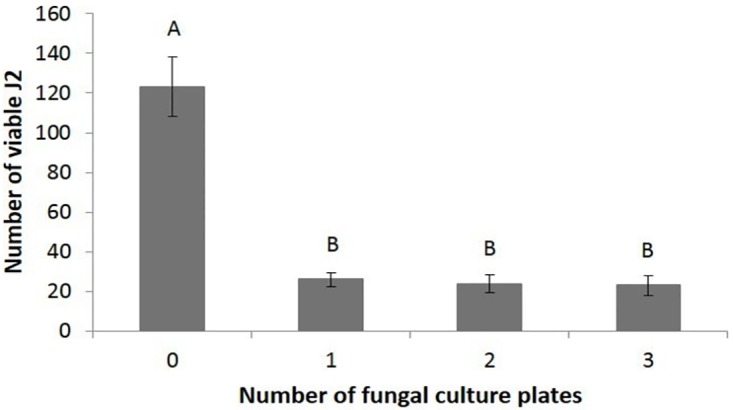
Effect of D. cf. concentrica culture plate on M. javanica J2 viability.J2s were exposed to 0–3 culture plates of D. cf. concentrica for 48 h. The numbers on the x-axis represent the numbers of Petri plates (50 mm in diameter, containing 5 mL of growth medium, and the fungal culture) in each 1-L sealed box. The number 0 indicates control treatment in which the nematodes were not exposed to the fungal culture plate. The viable J2s were separated using 30 μm sieves, and the numbers on the y-axis represent the numbers (mean ± SE) of viable J2s counted following the incubation. There were 10 repetitions, each using 300 J2s. The results were subjected to analysis of variance followed by the Tukey-Kramer multiple comparison test; different letters above the bars indicate a significant difference between samples at P ≤ 0.05. The experiment was independently repeated three times, each time with similar results.